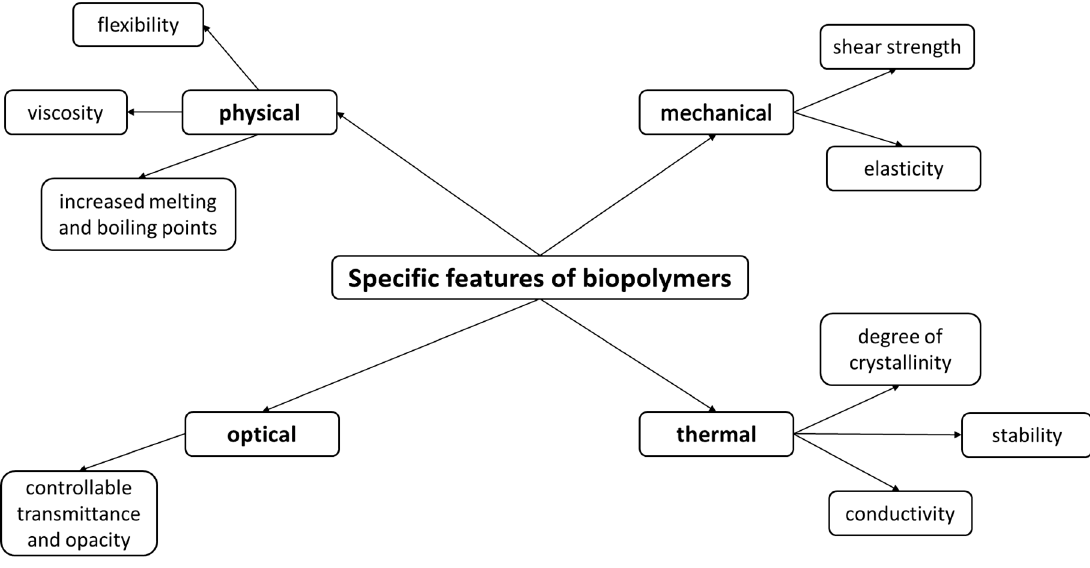
Figure 3. Specific features of biopolymers.